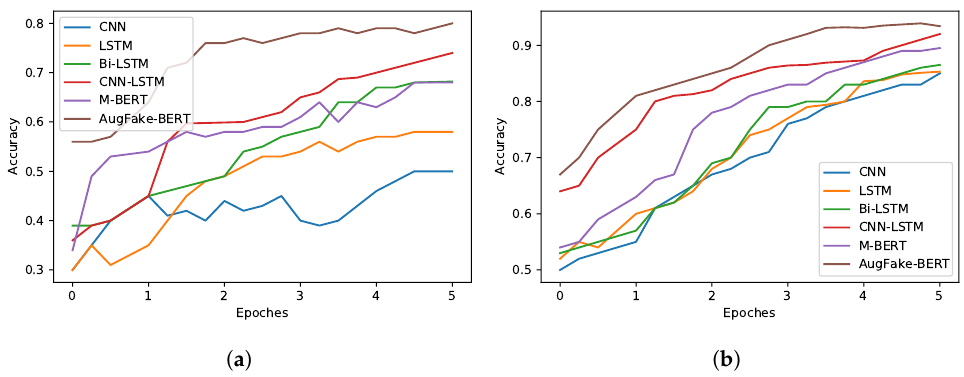
Figure 10. The effect of accuracy of the CNN, LSTM, Bi-LSTM, CNN-LSTM, M-BERT, and AugFake- BERT models on the original and augmented dataset. ( a ) Original dataset; ( b ) Augmented